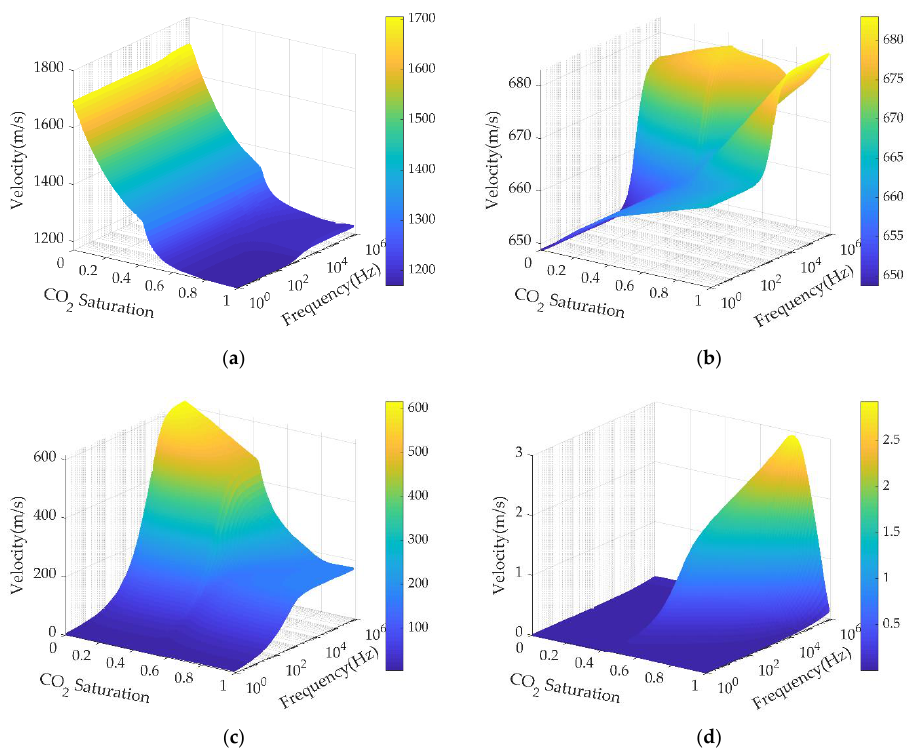
Figure 1. Effects of frequency and CO 2 saturation on the phase velocities of four waves: ( a ) the first compressional wave (P1); ( b ) the shear wave (S); ( c ) the second compressional wave (P2); ( d ) the third compressional wave (P3).